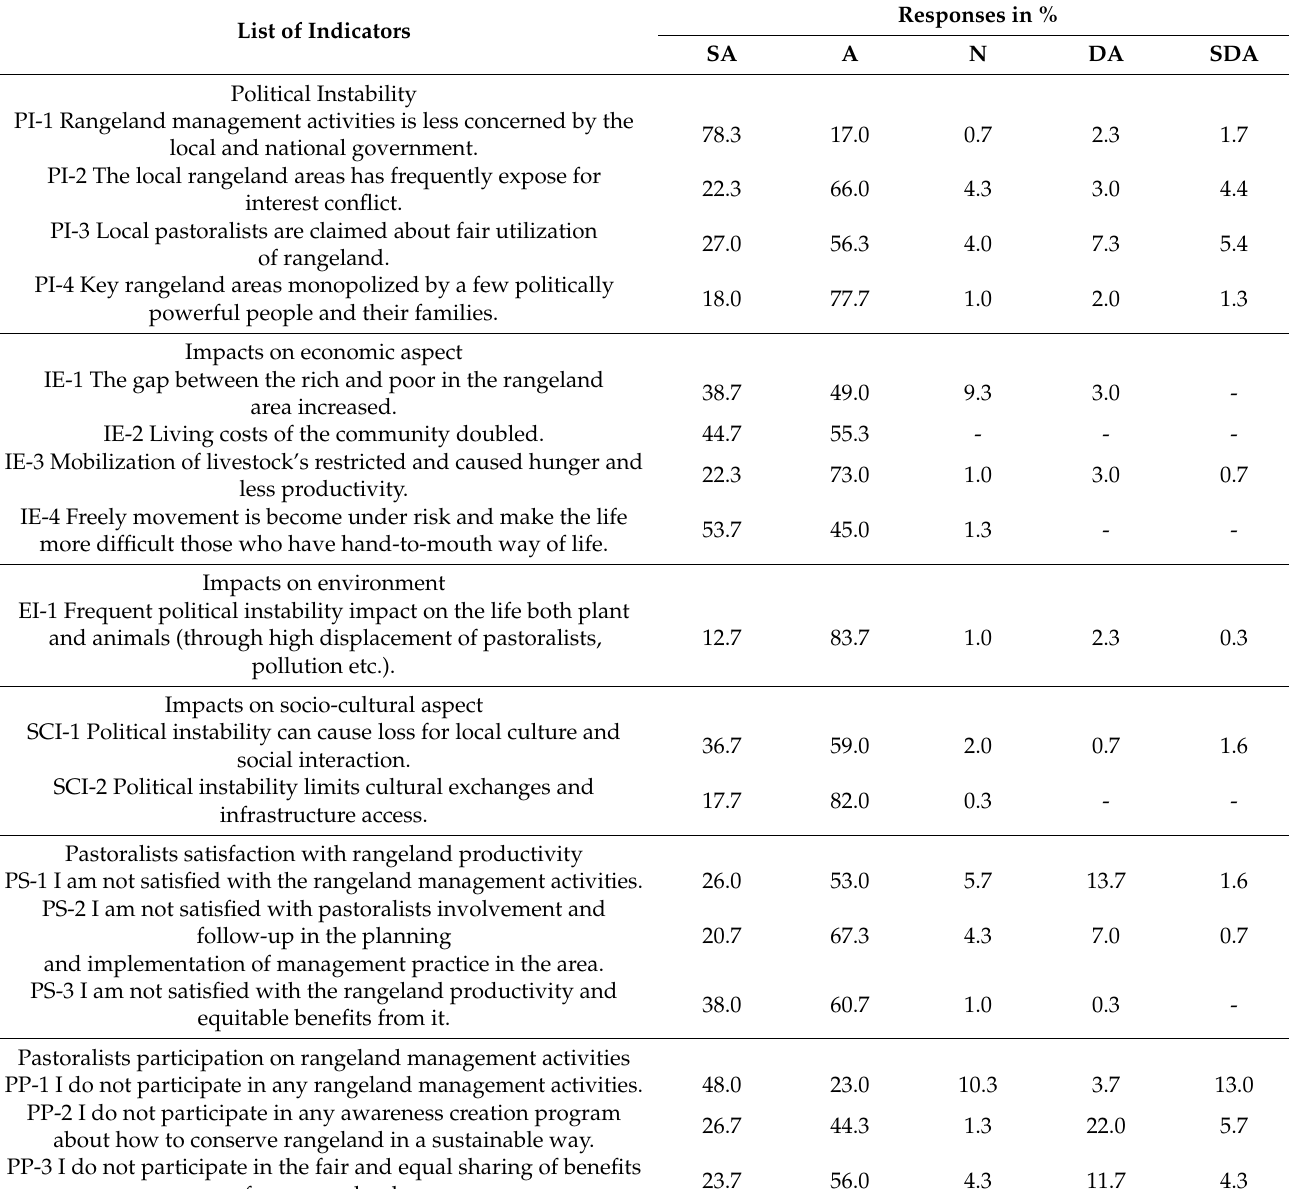
Table 2. Results of pastoralists’ data about indicators of sustainable rangeland management ( n = 300). List of